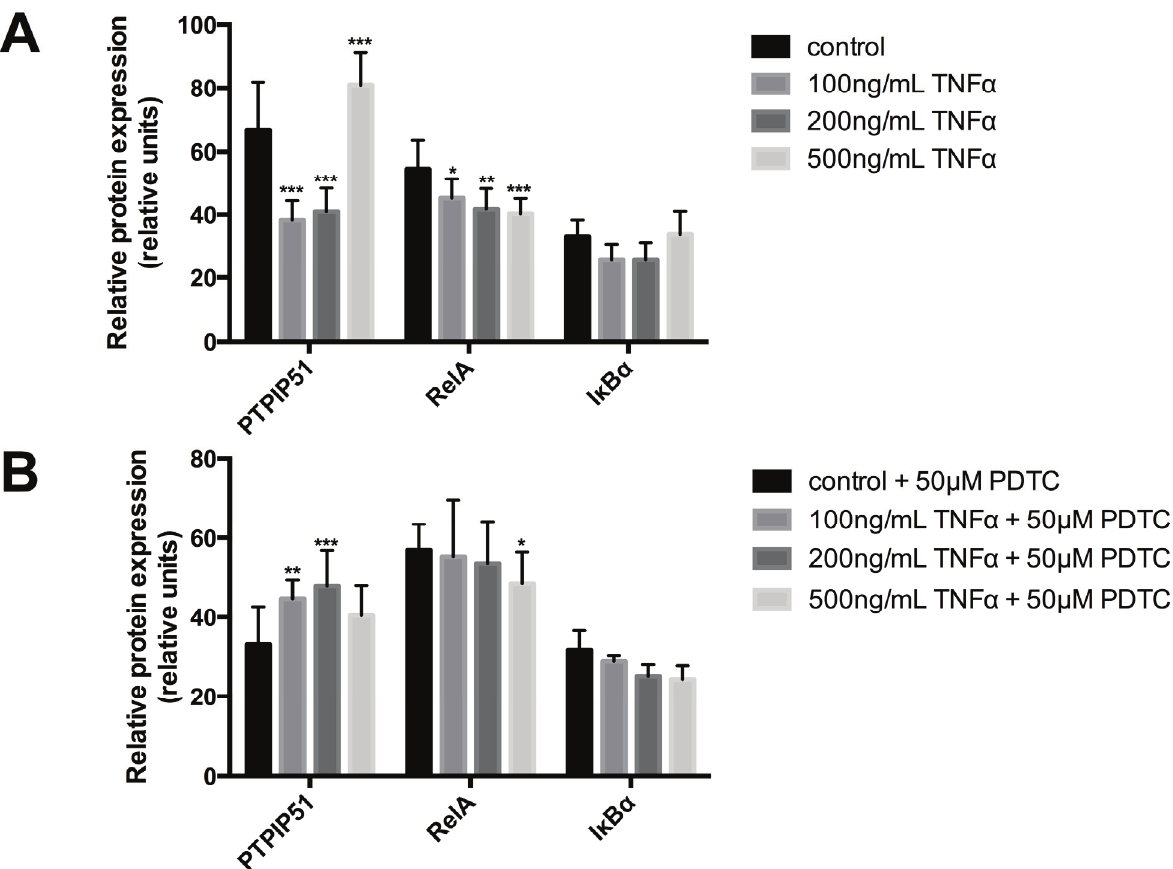
Figure 2. Semiquantitative expression of PTPIP51, RelA and I(cid:2)B protein in keratinocytes. ( A ) PTPIP51 protein (left panel), RelA (middle panel) and in I(cid:2)B (right panel) in untreated controls, 100 ng/mL TNF(cid:3) treated cells, 200 ng/mL TNF(cid:3) treated cells, 500 ng/mL TNF(cid:3) treated cells. * ( p < 0.05), ** ( p < 0.01), *** ( p < 0.001); ( B ) PTPIP51 protein (left panel), RelA (middle panel) and I(cid:2)B (right panel) in controls treated with 50 μM PDTC, 100 ng/mL TNF(cid:3) and 50 μM PDTC treated cells, 200 ng/mL TNF(cid:3) and 50 μM PDTC treated cells, 500 ng/mL TNF(cid:3) and 50 μM PDTC treated cells. * ( p < 0.05), ** ( p < 0.01), *** ( p <